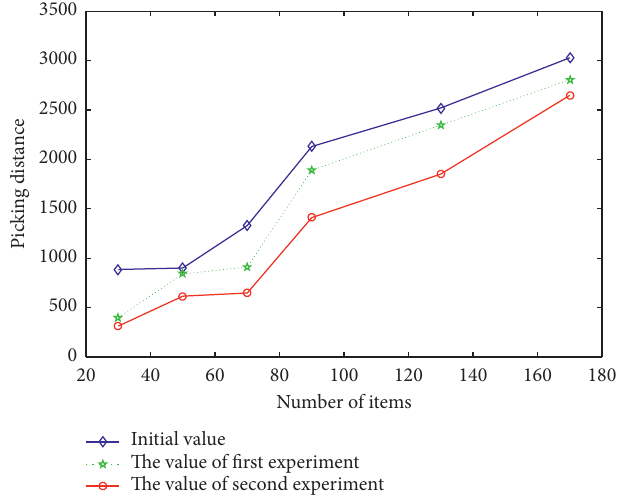
Figure 10: The comparison results of the picking